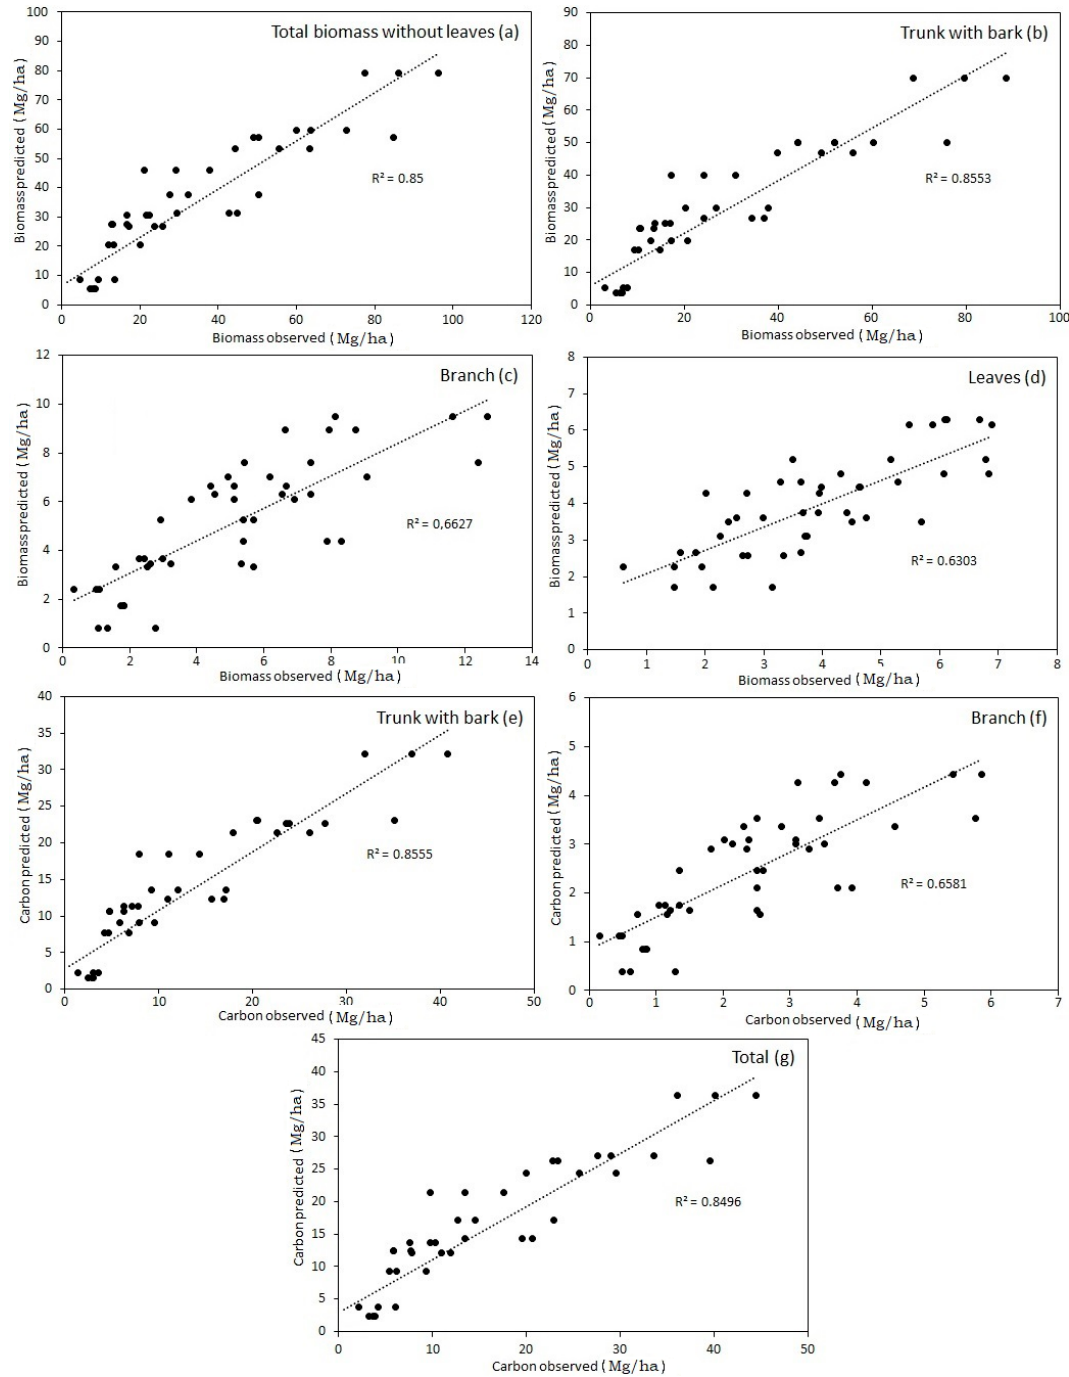
Figure 5. Observed vs. predicted for total biomass without leaves ( a ), for biomass trunk with bark ( b ), for biomass branch ( c ), for biomass in leaves ( d ), carbon in trunk with bark ( e ), carbon in branch ( f ), total carbon ( g ) in short rotation Gmelina arborea plantations in two different locations in Costa Rica.